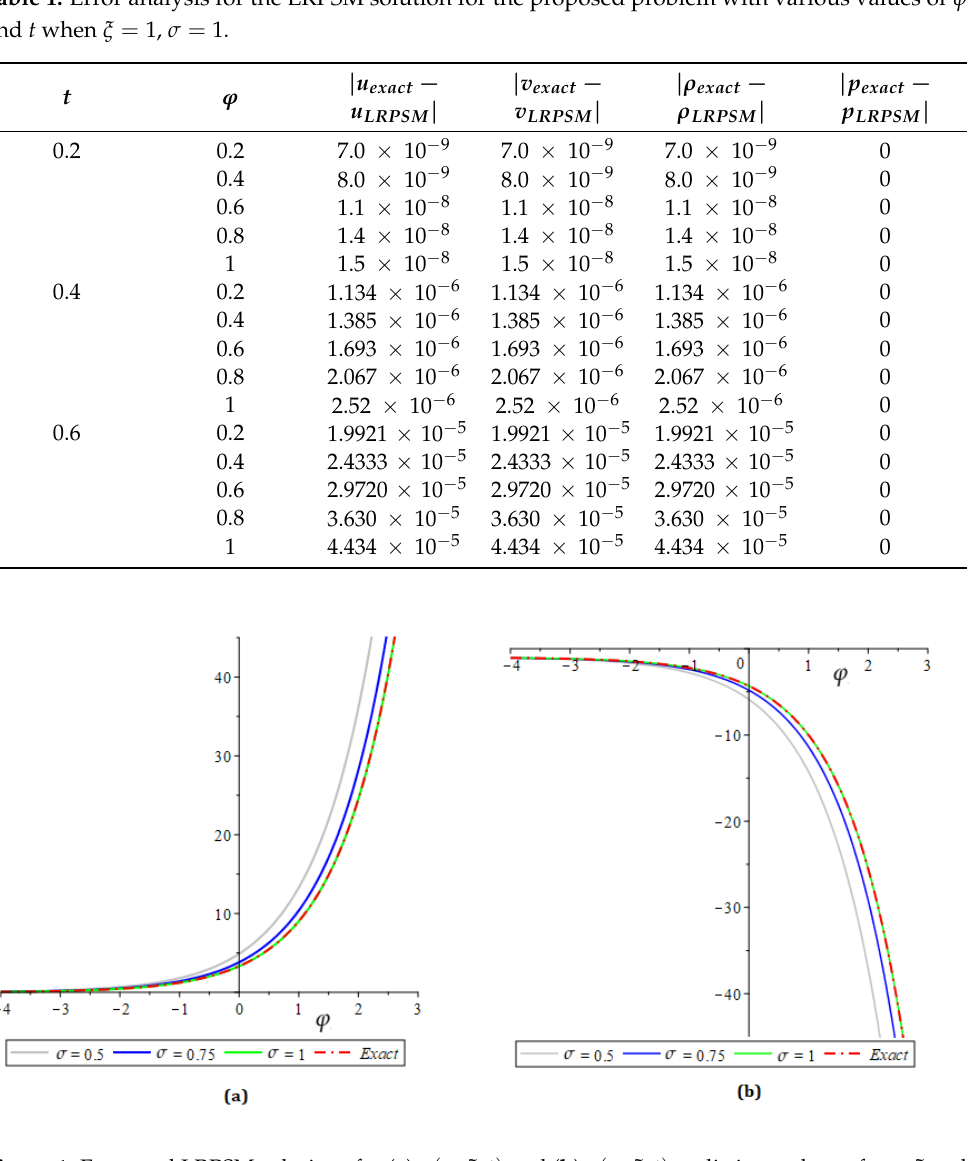
Figure 1. Exact and LRPSM solutions for ( a ) u ( ϕ , ξ , t ) and ( b ) v ( ϕ , ξ , t ) at distinct values of σ at ξ and t =